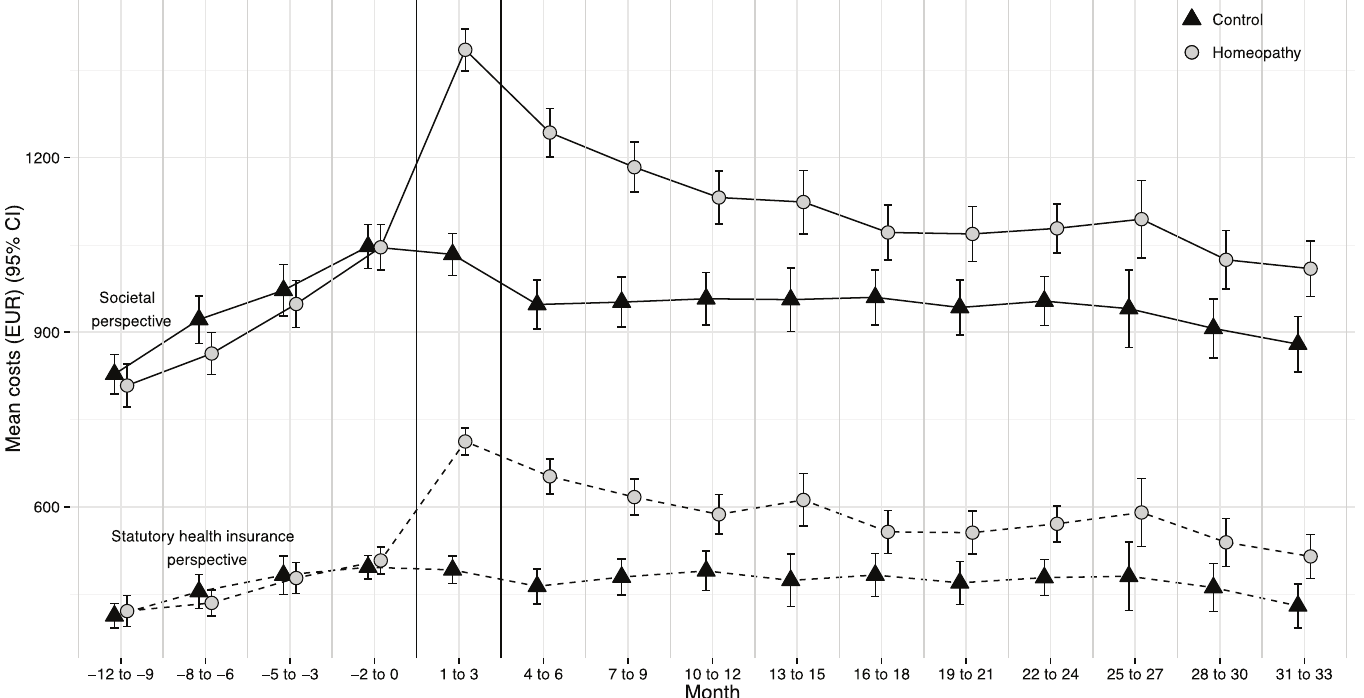
Fig 1. Mean overall cost (EUR) progression by group from the societal and statutory health insurance perspectives from month -12 until month 33. Error bars denote 95% CIs. Months 1 to 3 indicate the start of the integratedcare model. Costs from month 1 onwardare adjustedto baselinecosts (month -12 to month